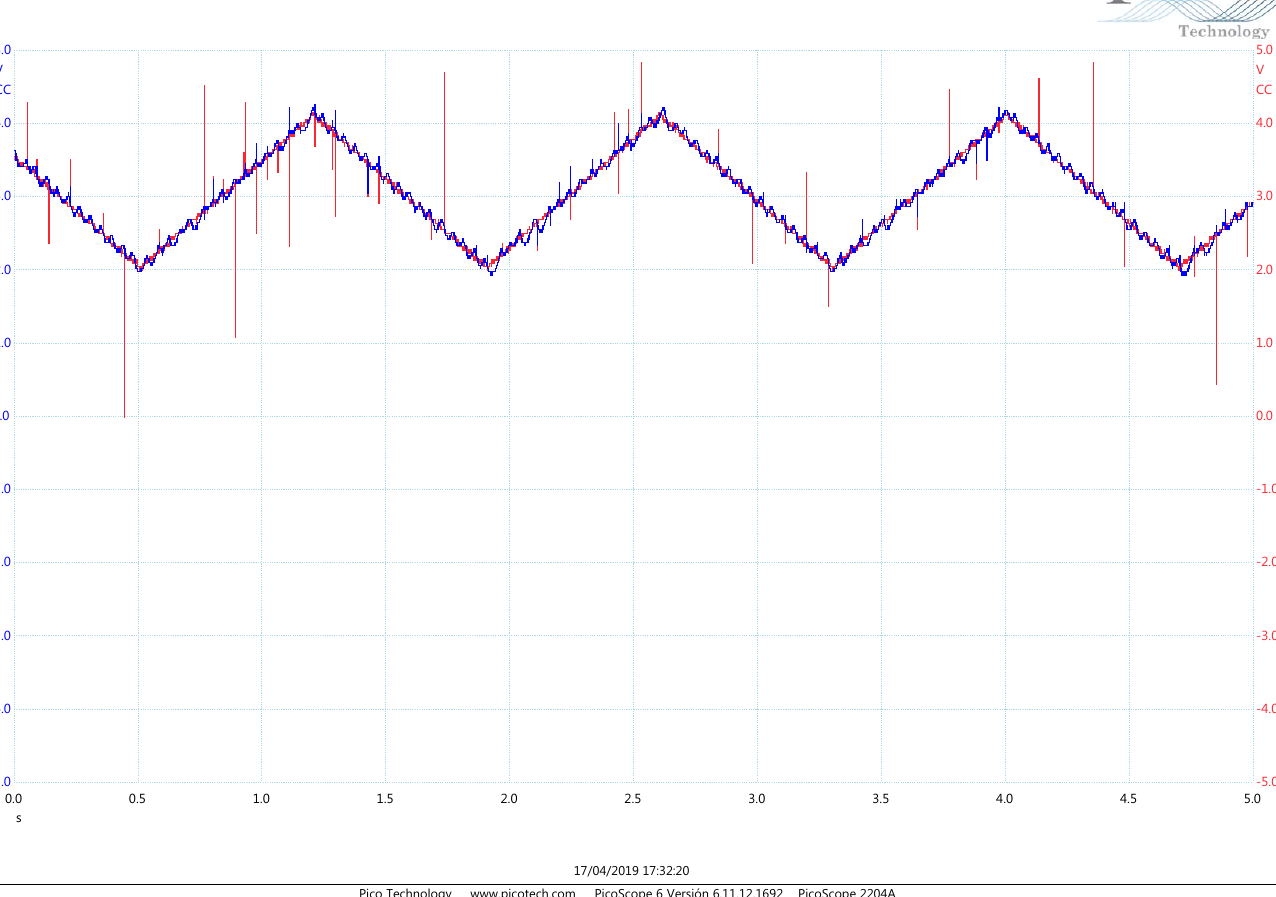
Figure 6. Experimental results. The blue line is the measured throttle angular position and the red line is the programmed reference. From these results, it is observed that the throttle-plate angular position follows the desired trajectory by performing a zig-zag displacement around it. Hence, the tracking error is bounded and it may depend on the size of the hysteretic-loop controller